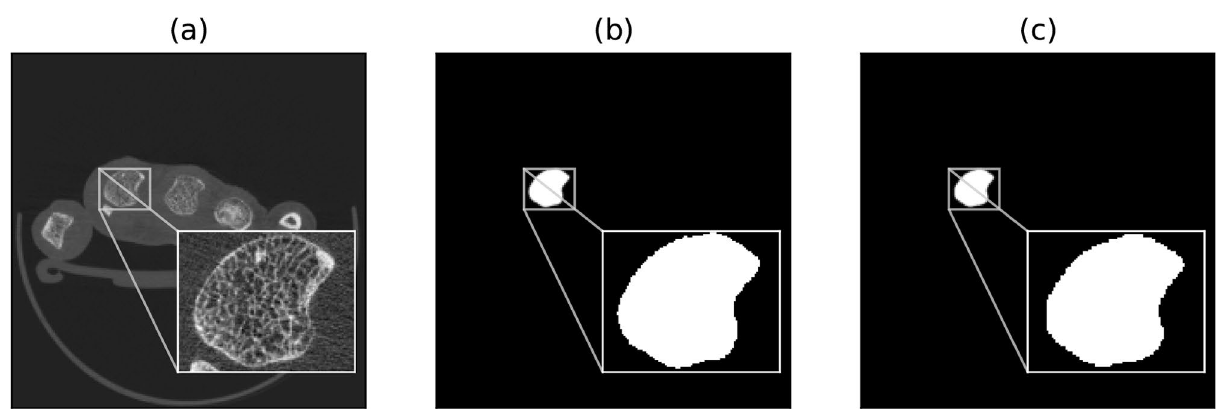
Figure 2. Overview of a slice of the HR-pQCT volume ( a ), the manual segmentation ( b ), and the network- based segmentation ( c ). Note, that the input to the network are the whole slices of the